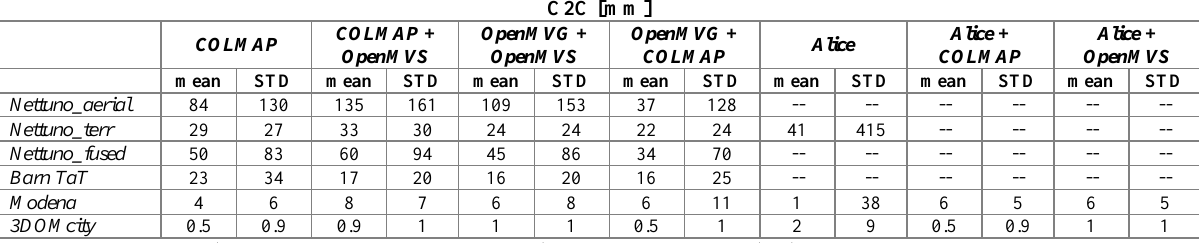
Table 6. C2C analyses (mean and standard deviation – STD) between ground truth (GT) reference and achieved results. Note that all Nettuno datasets were scaled down to half resolution for computational efficiency. Dash lines (--) means no data/results available due to bad orientation